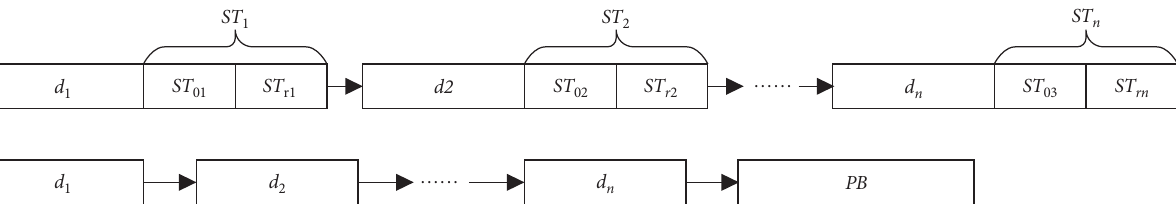
Figure 6: Buffer determination principle of the refined RSEM.